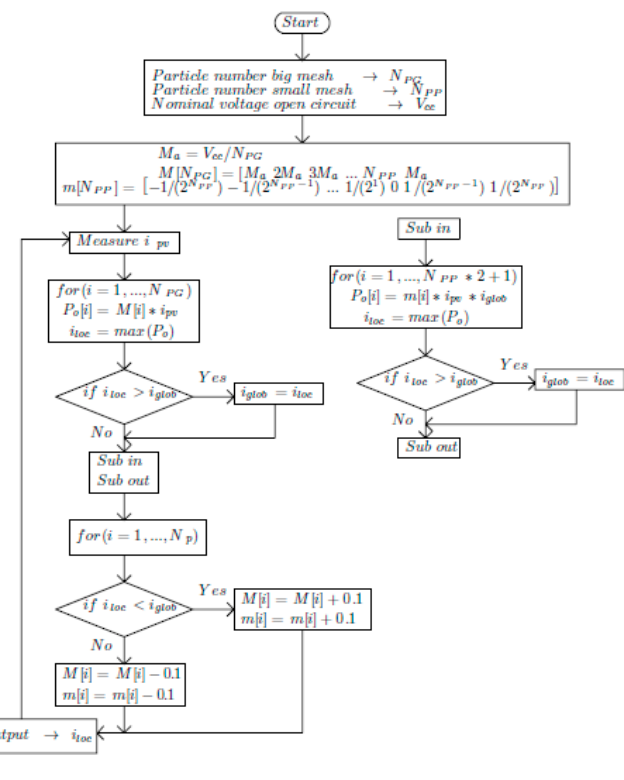
Figure 5. Proposed IPSM algorithm.